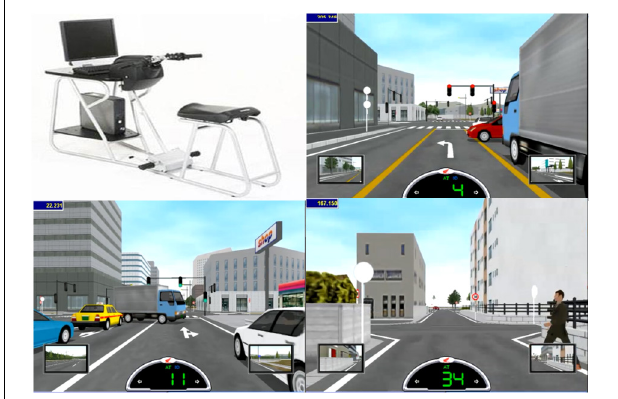
FIGURE 1 | The HRT simulator used in the present study (top-left panel) and three examples of risky